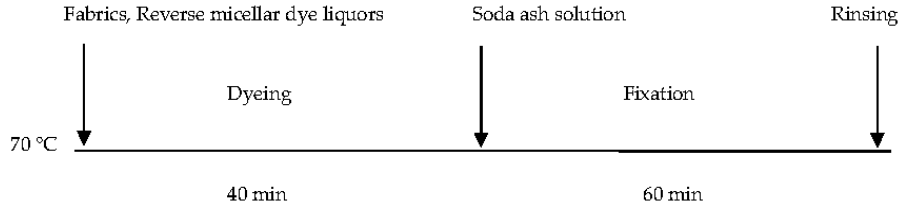
Figure 2. Dyeing profile of cotton in the reverse micellar system using octane. Table 3. Concentration of soda ash used for colour fixation.